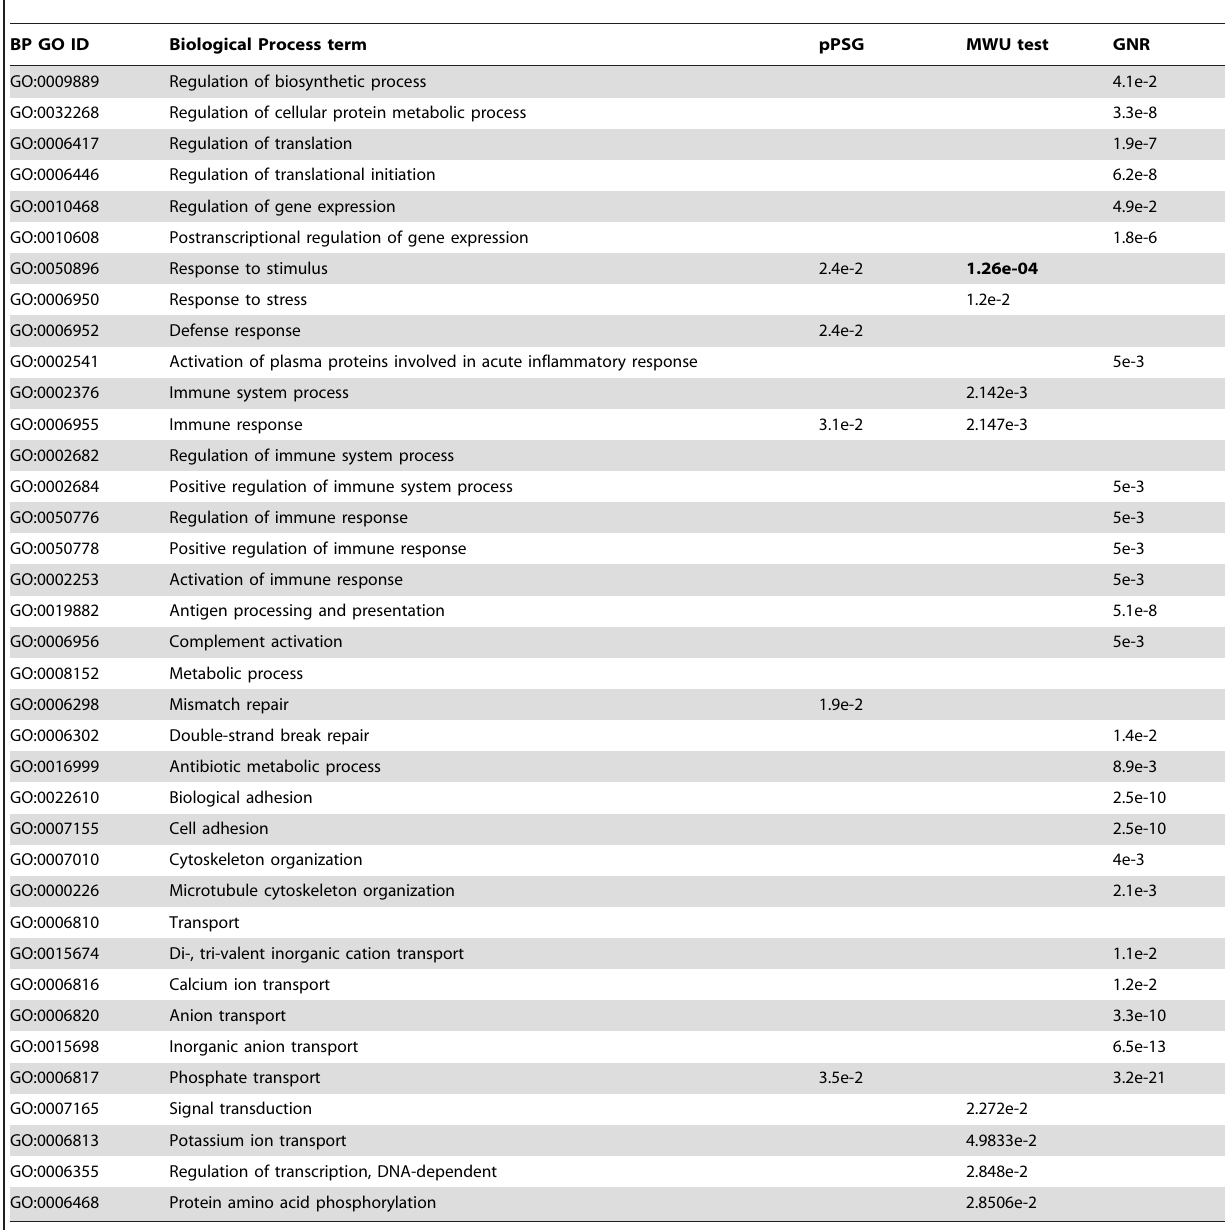
Table 1. Biological Process GO terms enriched with either pPSG, with genes displaying small P -values as given by the MWU test, or with